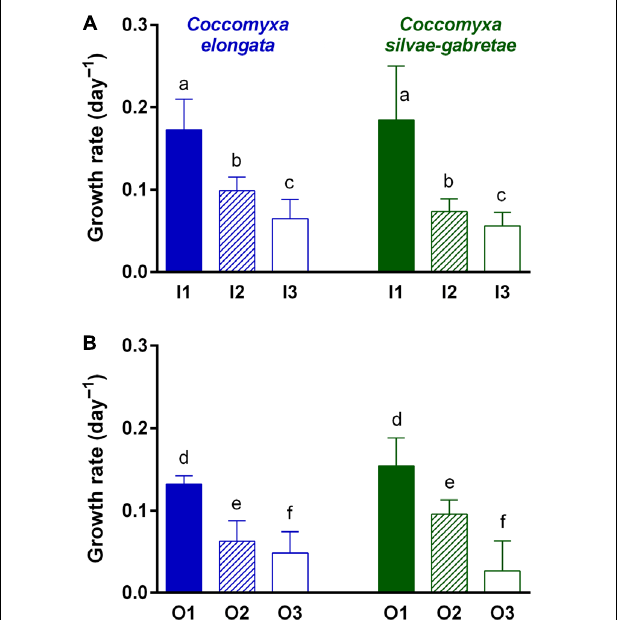
FIGURE 2 | Comparison of growth rates of the Coccomyxa cultures in P-replete (1) and P-depleted (2 and 3) media with either inorganic (I; top: A ) or organic (O; bottom: B ) P source. Columns are means, bars represent SDs; note that scales are the same. Differences among treatments were tested using three-way ANOVA with a post hoc Tukey HSD test; lower case letters above the columns (a–f) indicate significant differences among treatments (see Table 1 for summary